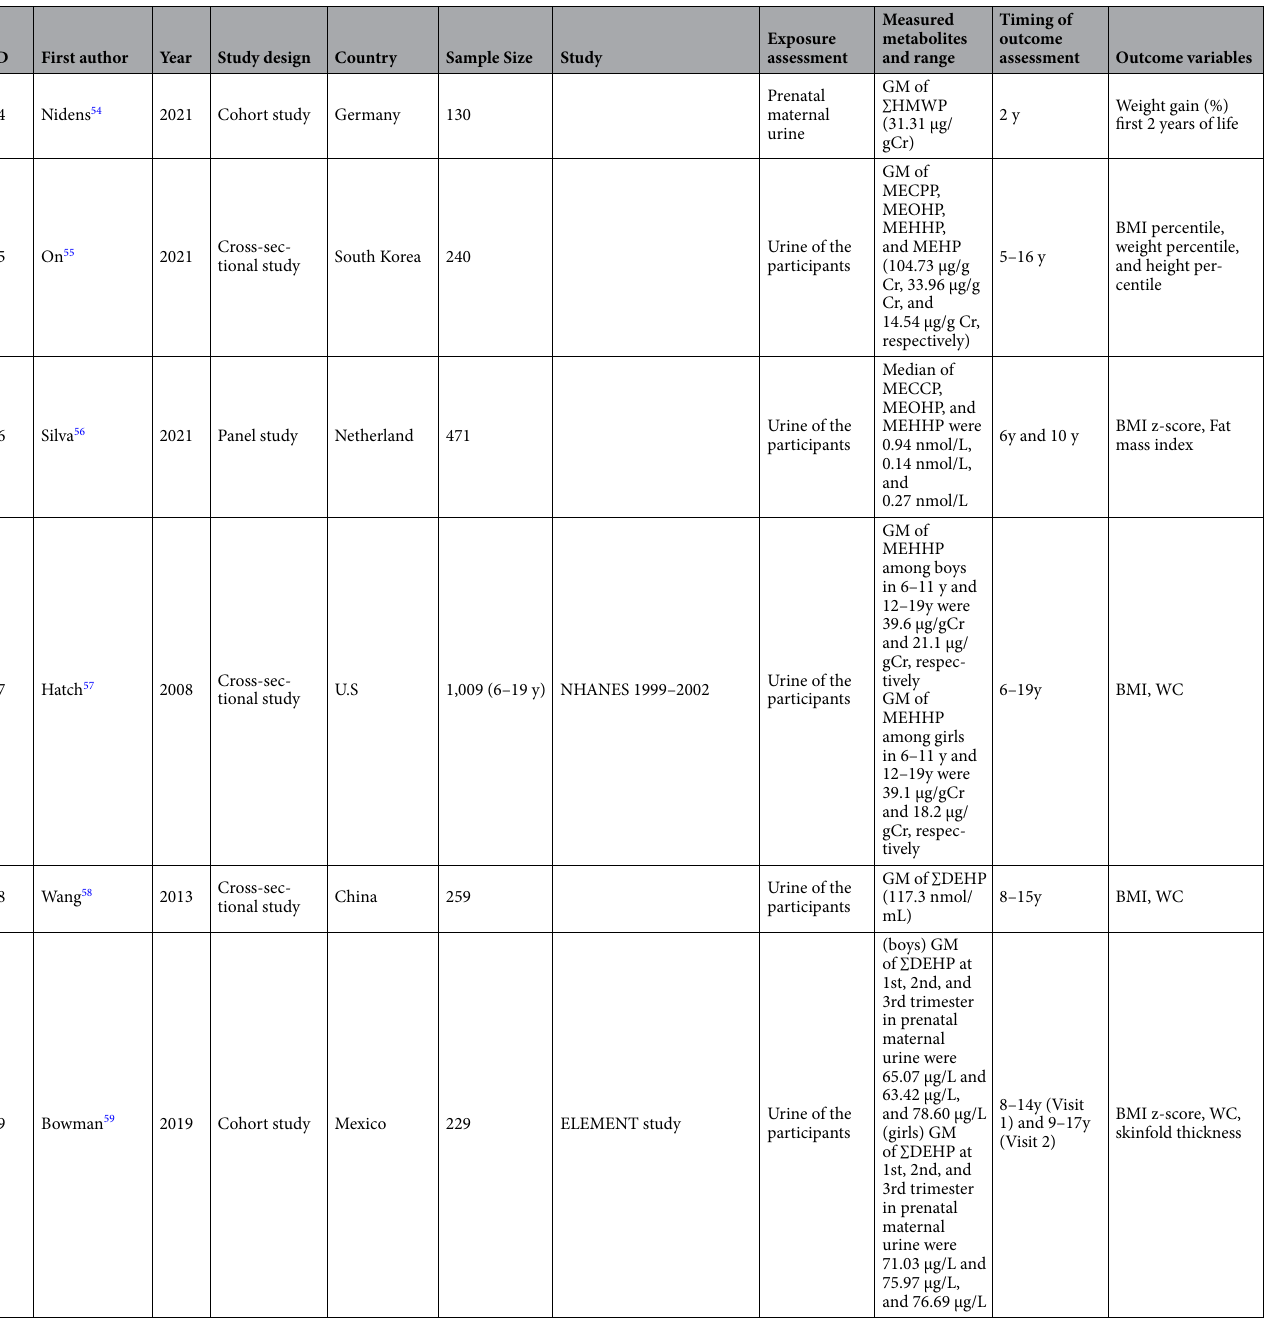
Table 1. Summary of studies included in the systematic review. MEHHP mono-(2-ethyl-5-hydroxy-hexyl) phthalate; MEOHP mono-(2-ethyl-5-oxo-hexyl) phthalate; MnBP mono-n-butyl phthalate (MnBP);